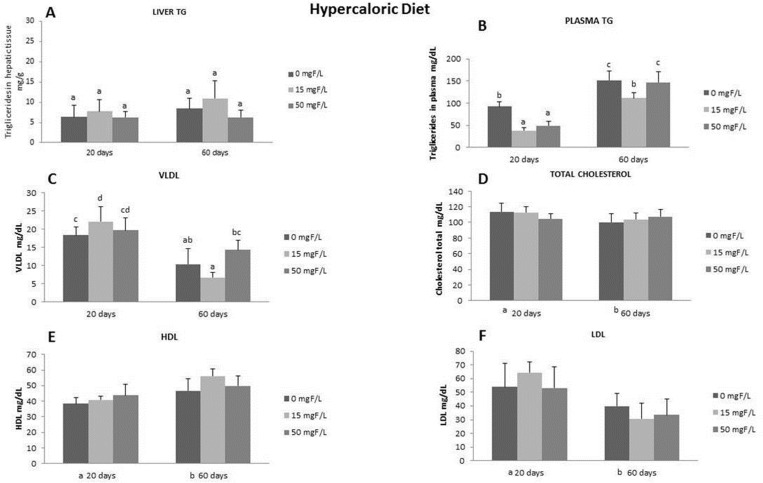
Lipid profile in animals fed hypercaloric diet: Means of the lipid profiles in plasma and liver of rats treated with hypercaloric diet receiving different fluoride concentrations in the drinking water for 20 or 60 days. A) TG plasma; B) TG liver, C) VLDL, D) Cholesterol, E) HDL, F) LDL. For each variable, distinct upper case superscripts indicate significant differences among the groups (2-way ANOVA and Tukey’s test, p<0.05).